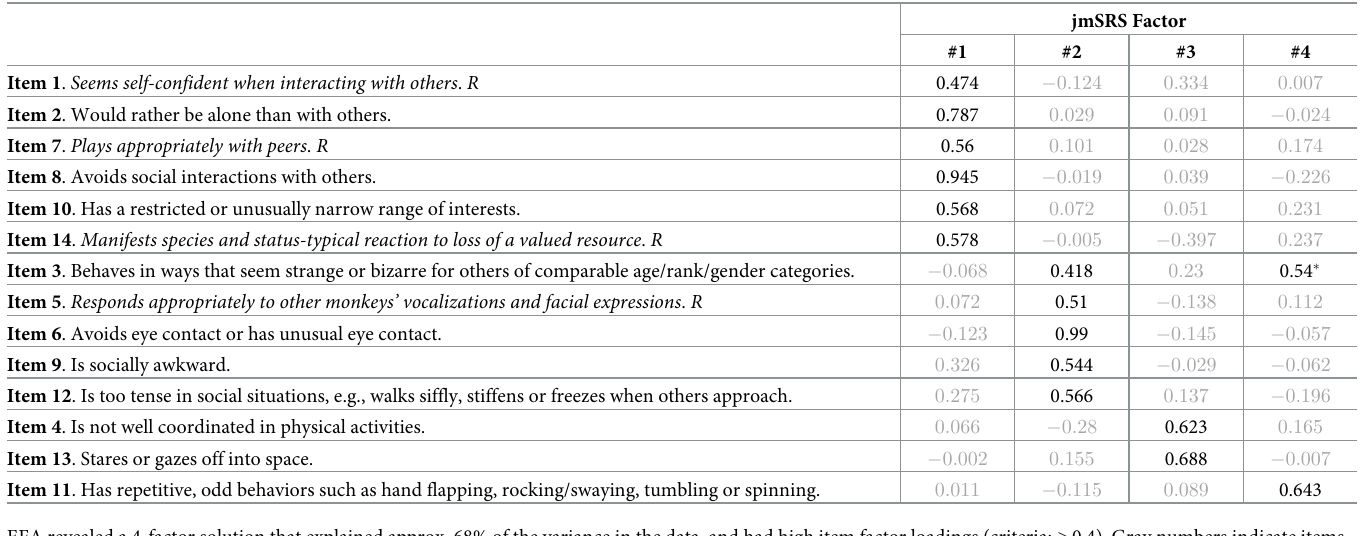
Table 3. Exploratory factor analysis (EFA) of the 14 jmSRS items: 4-factor